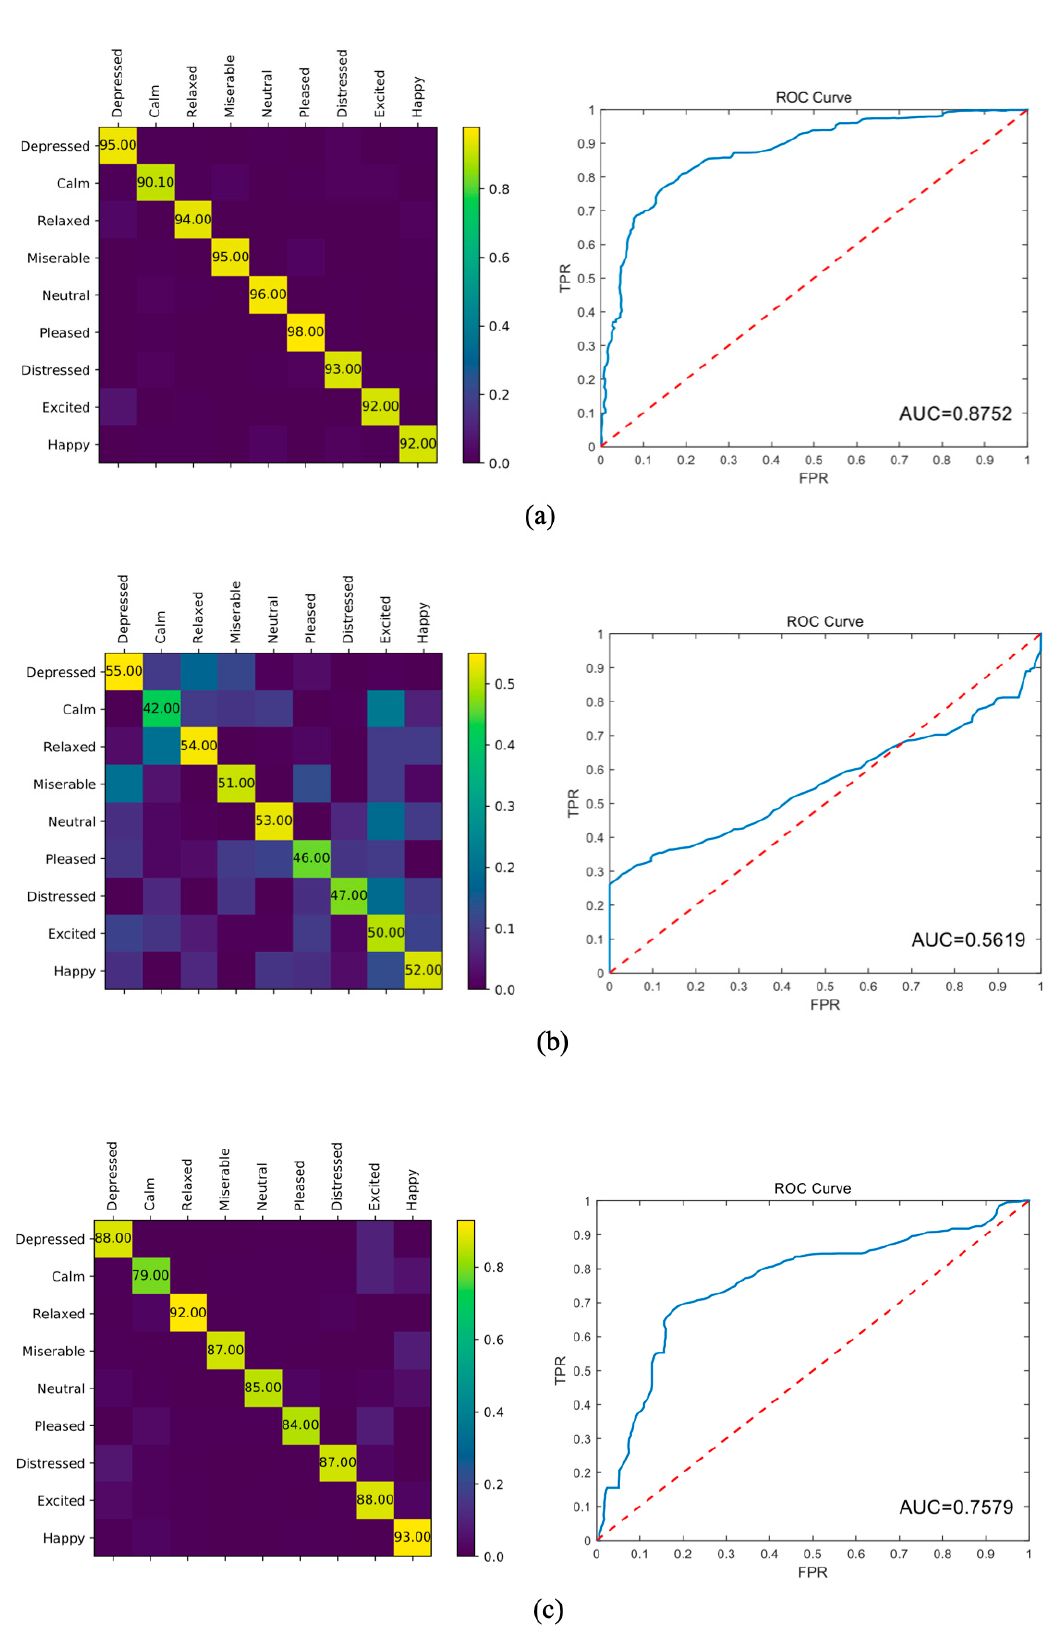
Figure 9. Results of the experiments with different dimensional datasets. Results obtained with ( a ) raw data; ( b ) removal of data corresponding to channels P3, P4, PZ, CPZ, CP3, and CP4; ( c ) removal of data corresponding to channels F3, F4, FZ, FP1, FP2, and